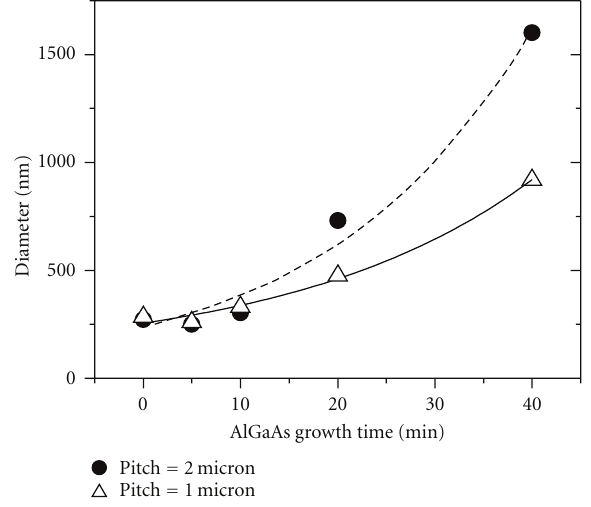
Figure 18: Dependence of nanowire thickness on AlGaAs growth time. Initial GaAs nanowire diameter was 270 nm. Nanowire dia- meter increased with AlGaAs growth time [29].